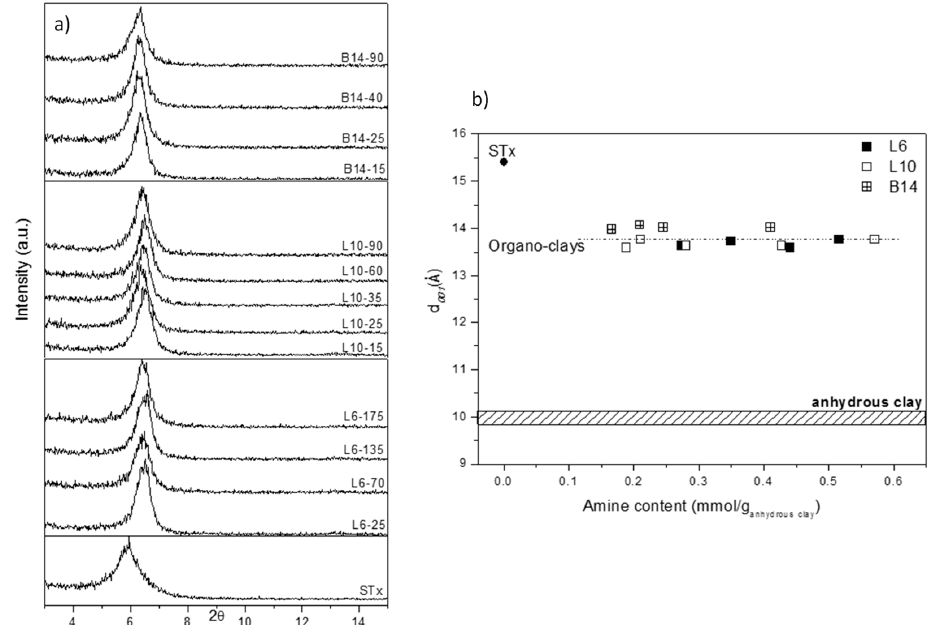
Figure 3. ( a ) X-ray diffraction (XRD) analysis of pristine and modified clays prepared at different initial amine concentrations and ( b ) Basal spacing (d 001 ) as a function of the amines content of modified clays, (for sake of comparison, d 001 of fully hydrated and dehydrated STx are reported).